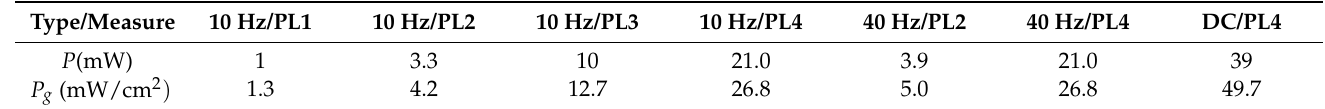
Table 1. Mean value of measurements for LEDs , power ( P ) in mW and power density ( P g ) in mW/cm 2 , for 3 diodes in a cluster. Square modulation frequencies of 10 and 40 Hz and continuous generation ( DC ) were tested for different power levels ( PL ).